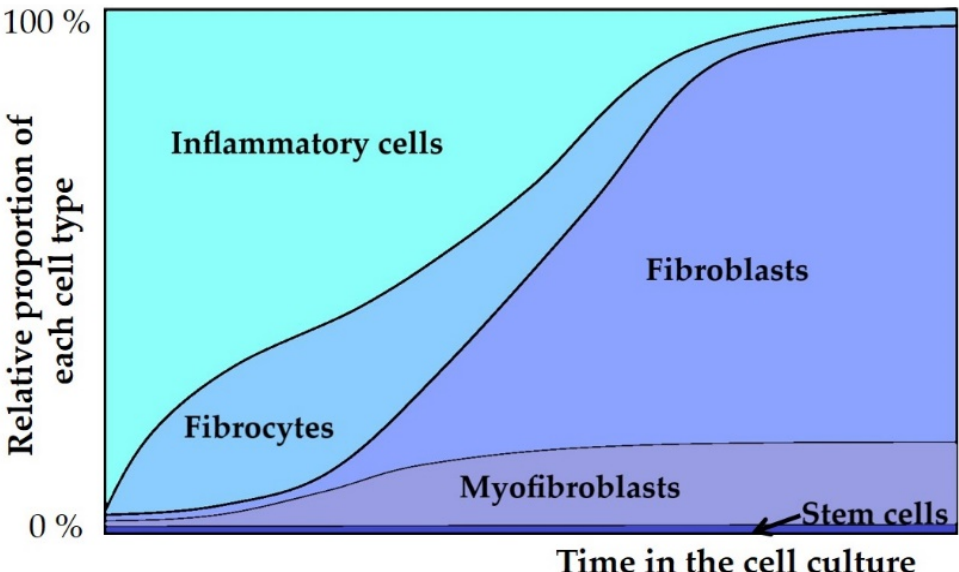
Figure 1. Schematic illustration of the relative proportions of various cell types during successfully- derived cell culturing. At the beginning of the culture, there are mainly inflammatory cells, but their proportion decreases rapidly. Fibrocytes are abundant during early phases and myofibroblasts become more abundant as the number of fibrocytes decreases. Fibroblasts proliferate actively and eventually overgrow other cell types. A small amount of stem cells can be seen throughout the cul- ture.